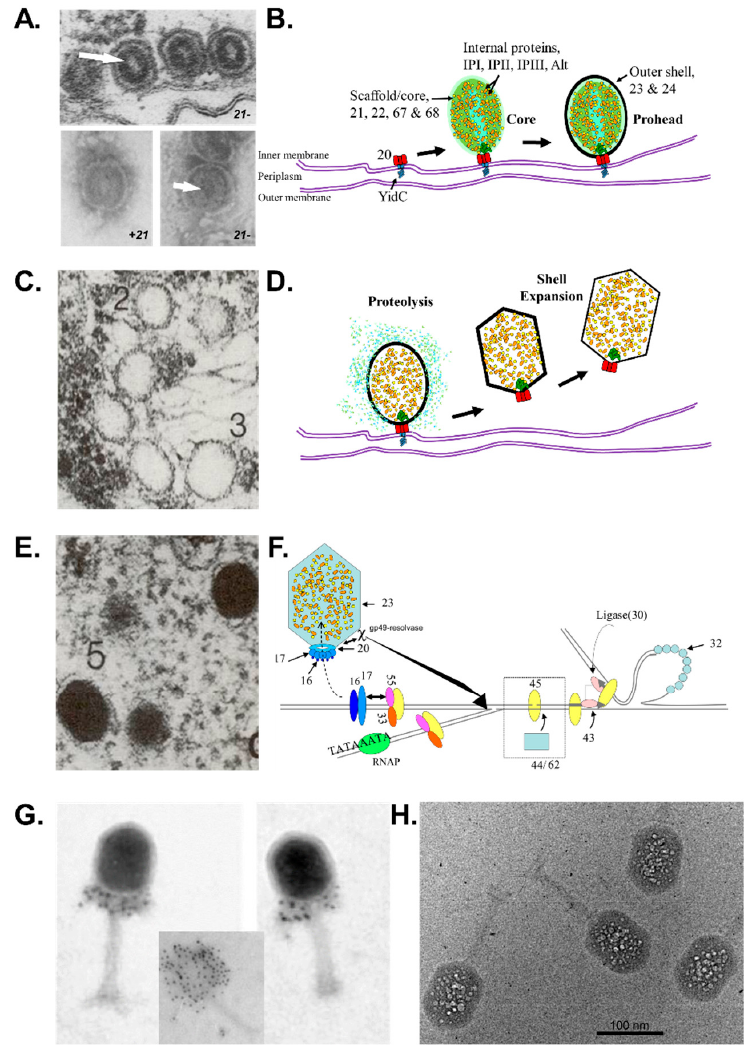
Figure 1. Overview of the major steps in T4 phage head assembly. ( A , B ) Assembly initiates via the formation of a protein core anchored to the E. coli inner membrane via the portal, and around which the major capsid protein concomitantly assembles. Only in the absence of gp23 can naked cores be observed. ( A ) Electron microscopy of proheads produced by 21- mutants in vivo (upper, thin section) and in vitro (lower). White arrow indicates a central hole in proheads assembled in the absence of the prohead protease (adapted from van Driel, Traub and Showe [6]). ( C , D ) Proteolytic maturation involves cleavage and removal of scaffold/core proteins as well as the propeptides of the internal and shell proteins, release of the prohead from the inner membrane and semi-expansion of the shell. ( E , F ) Packaging of the genome into the prohead occurs via the action of the main packaging proteins, TerS (gp16) and TerL (gp17). ( C , E ). Electron microscopy of thin sections of wild-type T4-infected E. coli (reproduced from Black and Thomas [7]). ( F ) Scheme of how DNA packaging in vivo is integrated with late transcription, and DNA replication (reproduced from Black and Peng [8]). ( G ) Recombinant ∆ hoc phage particles after immuno-gold labelling with an anti-Hoc antibody (inset WT phage particle). The visualization of the “gold necklace” provided evidence that the portal structure contained fusion proteins (gp20-Hoc). Confirming the recombinant phenotype was important, as these particles had a central role in refuting the rotary portal packaging model (reproduced from Baumann, Mullaney and Black [9]). ( H ) Cryo-electron micrograph of a T4 Alt mutant imaged after the eighth exposure of a dose series of 16.5 el/Å 2 per exposure). The bubbles are generated from the internal proteins, which are inferred to be randomly positioned within the DNA, but excluded from a zone of about 100–110 Å directly under the outer shell (reproduced from Wu et al.